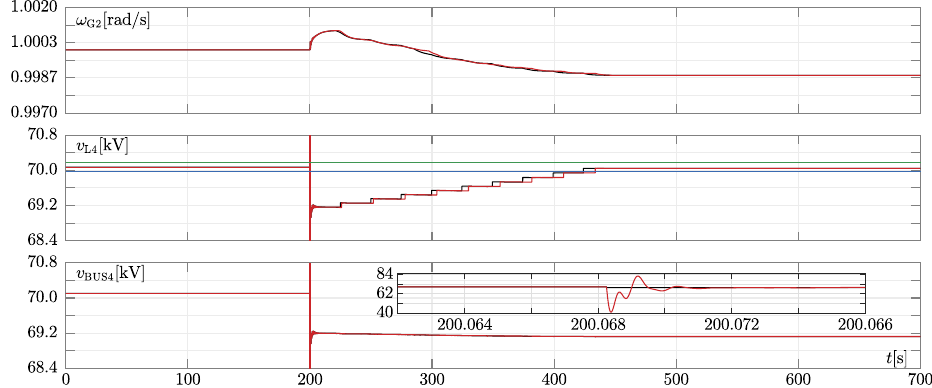
Figure 5. Simulation results of IEEE 14- Z and IEEE 14- ZD scenarios. The traces in each panel have an analogous meaning to those in Figure 3. In this case, the black and red traces in each panel respectively refer to the results of the IEEE 14- Z and IEEE 14- ZD scenarios. In the second and last panel, the voltage magnitude of BUS 4 is upper and lower clipped to better show voltage steps at a tap position change.